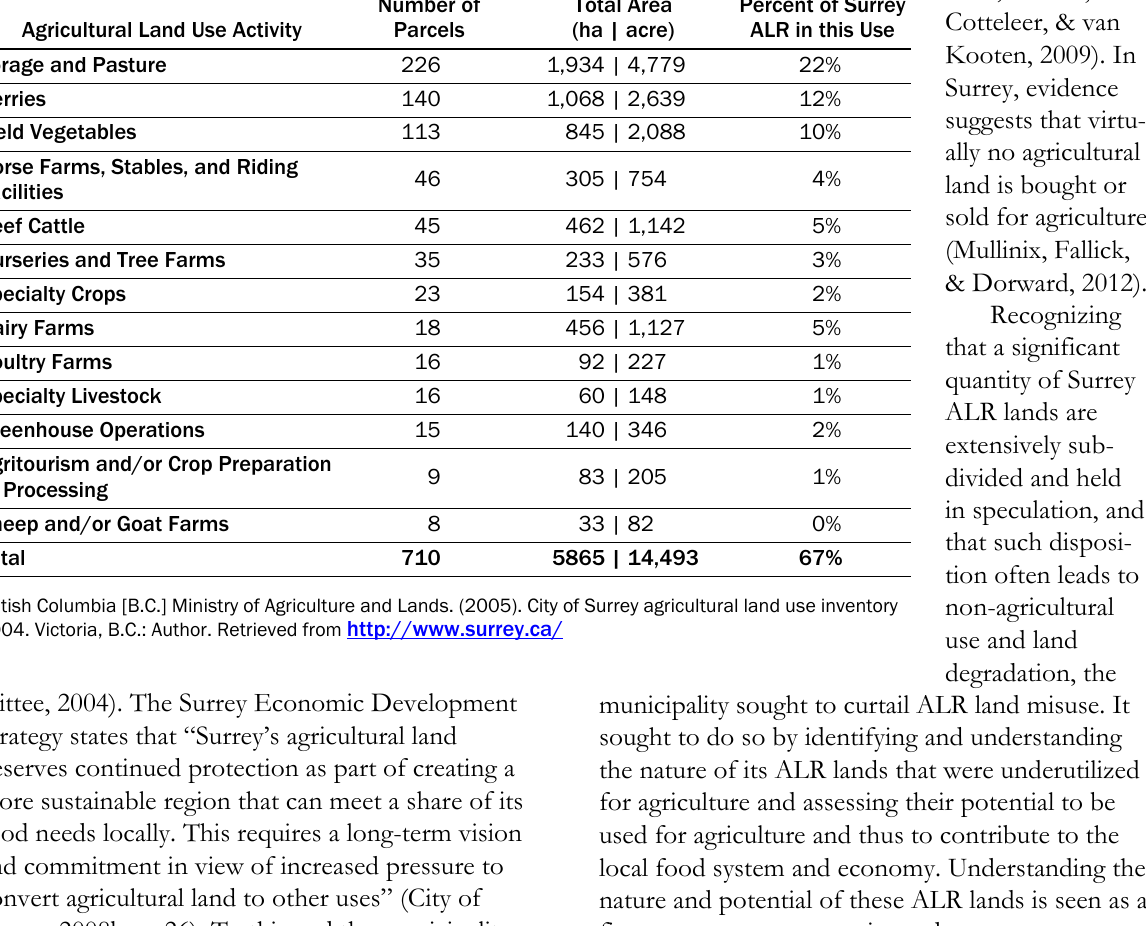
Table 1. Agricultural Land Use Activities on ALR Land in Surrey, BC (2006) Number Agricultural Land Use Activity